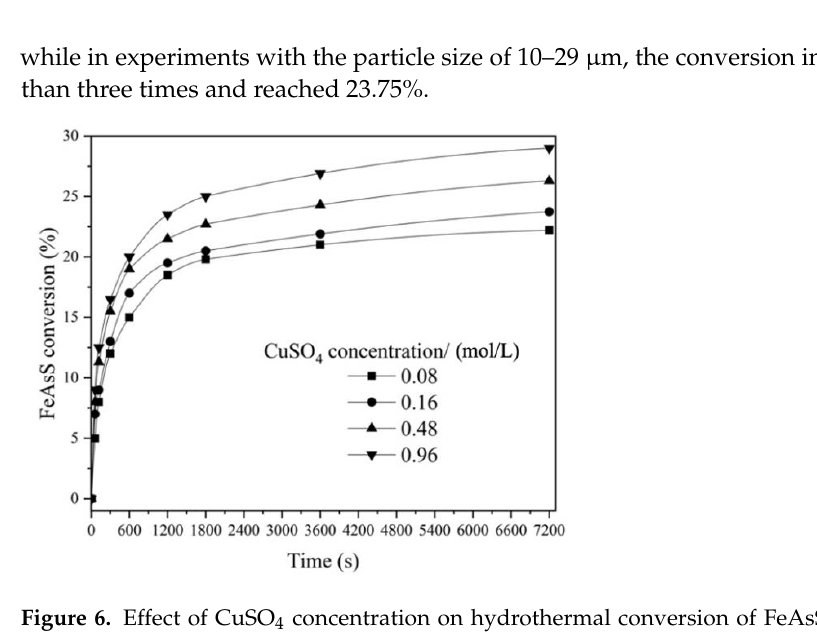
Figure 6. Effect of CuSO 4 concentration on hydrothermal conversion of FeAsS (100 rpm; 503 K; 0.1 mol/L of H 2 SO 4 ; 10 –29 μm).